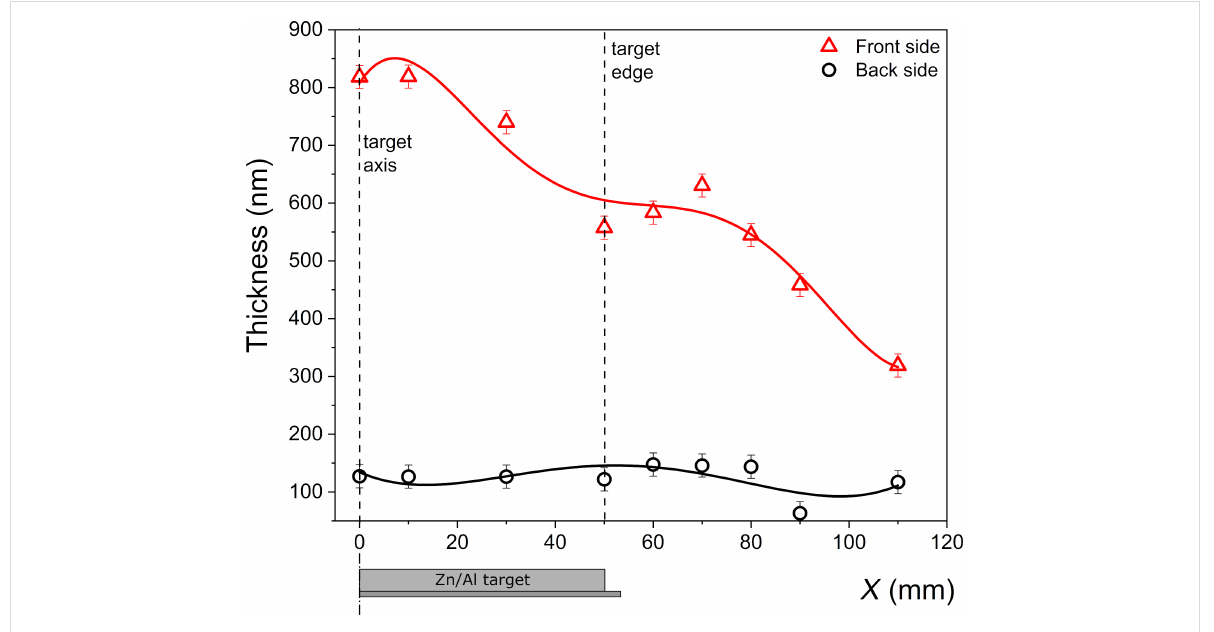
Figure 6: Dependence of thickness of thin films deposited on the front and back sides of the substrate as a function of the distance X from the Zn/Al target axis. The lines are to guide the eye.